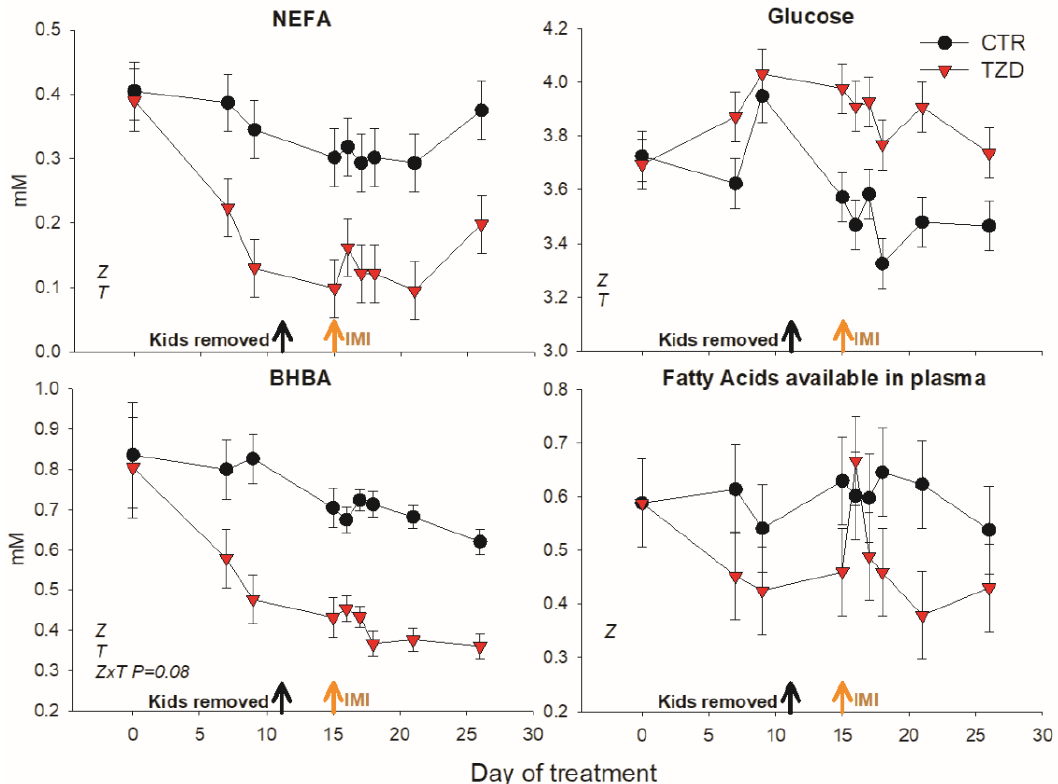
Figure 3. Non-esterified fatty acids (NEFA), glucose, β -hydroxybutyrate (BHBA), and estimated fatty acids present in plasma (mM NEFA + 3 × mM TAG) in goats receiving daily intra-jugular injection of 2,4-thiazolidinedione (TZD) or saline (CTR). Arrows indicate removal of kids and time of intramammary infusion of Strep. uberis in the right half of the mammary gland (IMI). Letters in the graph (a,b) denote significant effects of time (T), treatment (Z), and interactions (Z × T). The reported p -value is for tendencies. Error bars denote SEM. Table 2. Plasma concentration of metabolic parameters in dairy goats injected daily with 2,4-thiazolidinedione (TZD) or saline (CTR). Day of Treatment Parameter Group